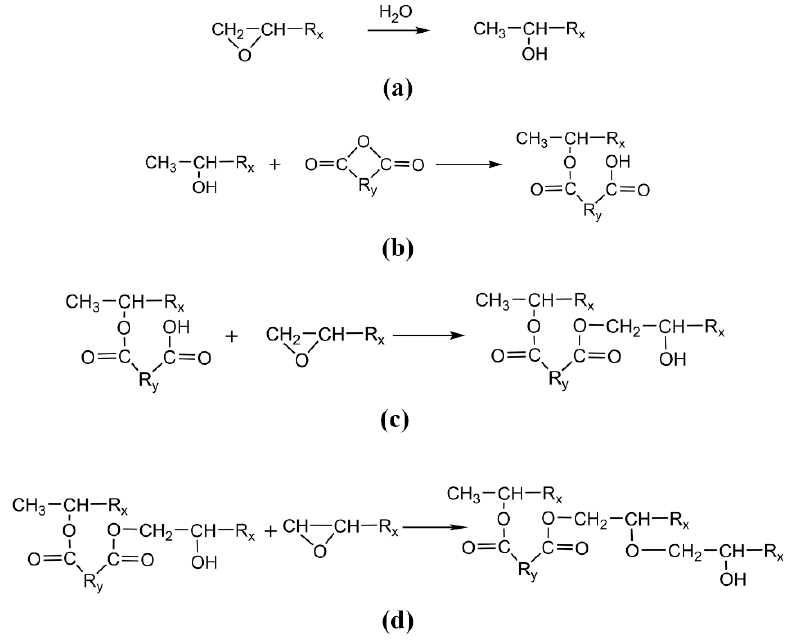
Figure 1. Curing reaction mechanism. ( a ) Micro-water opens the epoxy group to form a hydroxyl group; ( b ) hydroxyl and anhydride group produces monoester; ( c ) carboxyl and epoxy group forms diesters; ( d ) hydroxyl and epoxy groups etherify.